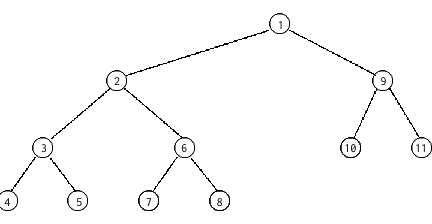
Fig. 2: A binary tree with 11 internal nodes, that are labelled by preorder traversal. Node 3 has three descendants and three